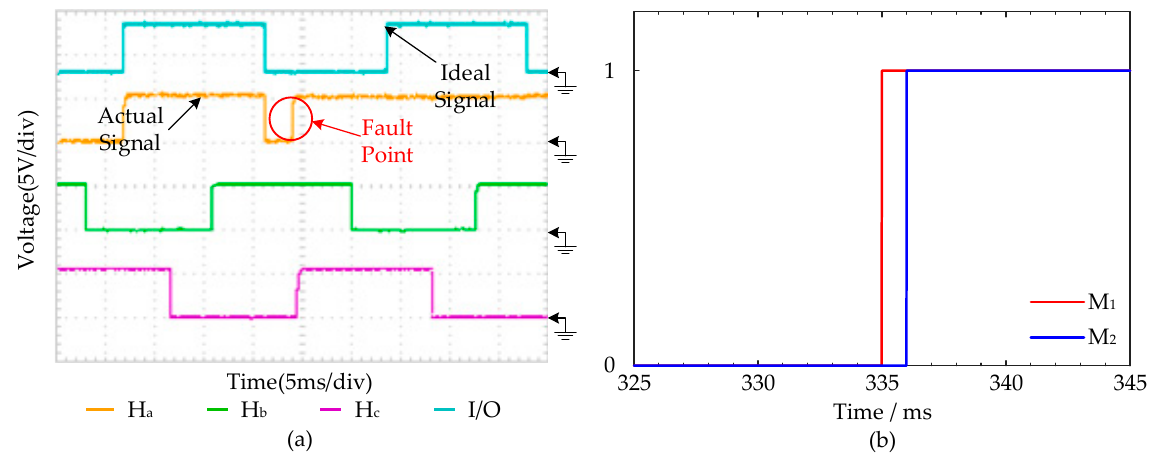
Figure 13. Hall Fault Type 1 diagnosis experimental results: ( a ) The Hall signal curves at Fault Type 1 and the ideal Hall signal curves. ( b ) The fault diagnosis experimental curves of M 1 and M 2 .